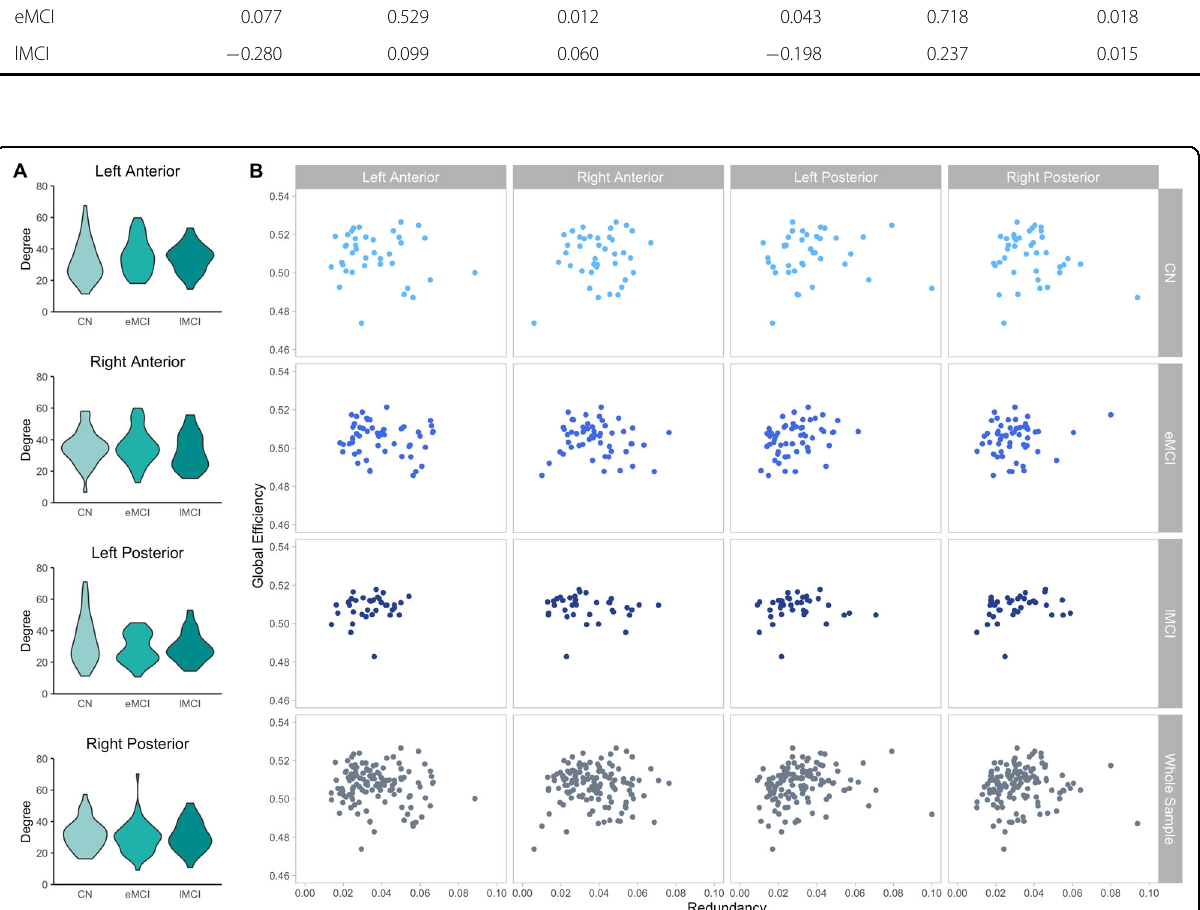
positive relationship between global ef fi ciency and left posterior hippocampal redundancy in the eMCI group, β = 0.32, p = 0.017, adjusted R 2 = 0.09. Results were